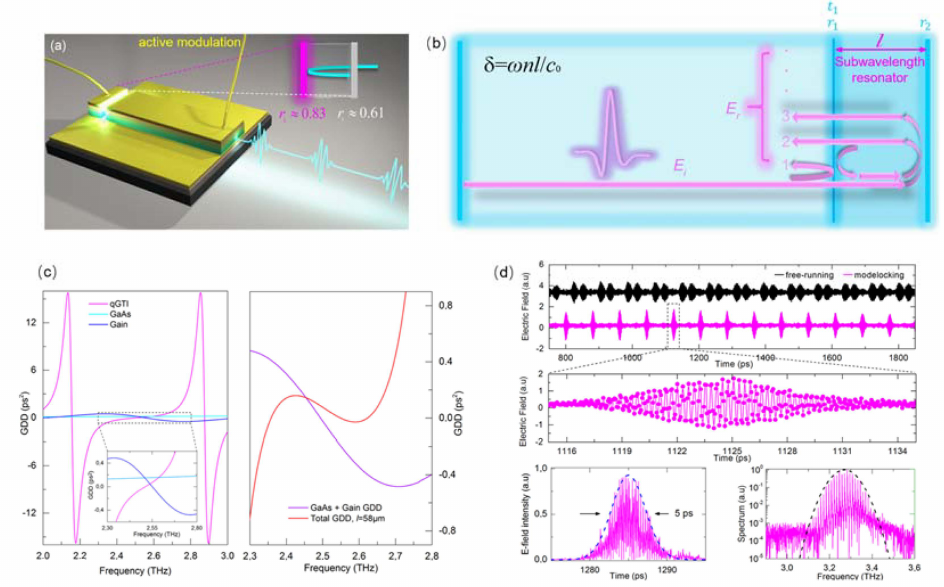
Figure 9. ( a ) The schematic of short-pulse generation based on on-chip dispersion compensation. ( b ) The schematic of dispersion compensation based on Gires–Tournois Interferometer. ( c ) Group Delay Simulations of the gain, material and GTI. Left: The individual GDD contributions of the GTI, GaAs and the QCL gain. Right: The total GDD for a 58 μ m (red) length GTIs. The contribution of the gain and material GDD is also shown for comparison. (Figure ( d ) from Ref [26], licensed under a Creative Commons Attribution (CC BY) license).